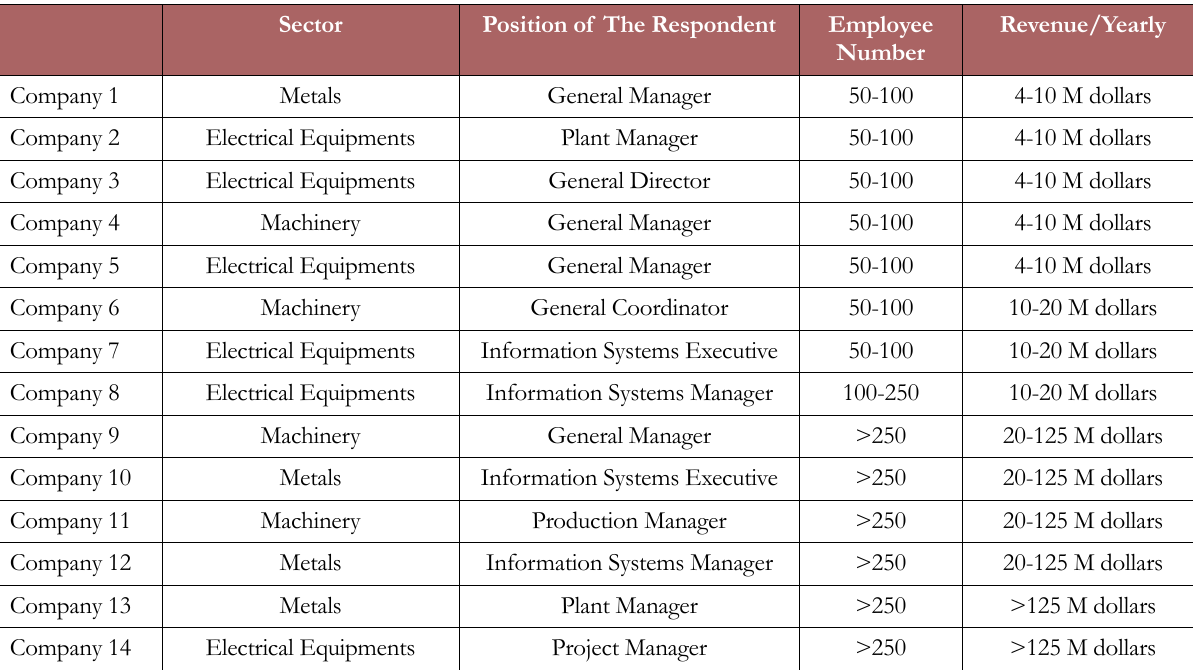
Table 2. The Characteristics of the Sample Companies and The Respondents